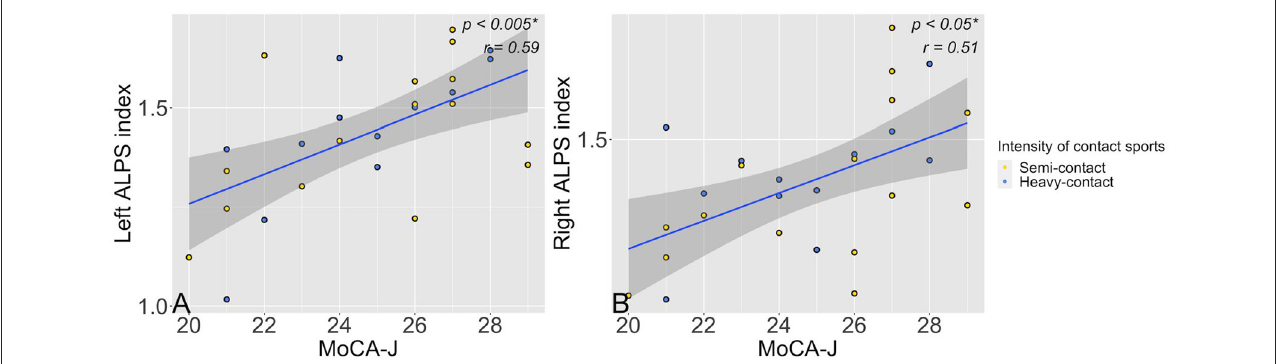
FIGURE3 Scatter plots show a significant ( p < 0.05) association between left (A) or right (B) ALPS along the perivascular space ALPS indices and MoCA-J scores in the semicontact (yellow dots) and heavy-contact groups (blue dots) combined. *Significant to P < 0.05. ALPS, analysis along the perivascular space; MoCA-J, Japanese version of the Montreal Cognitive Assessment.